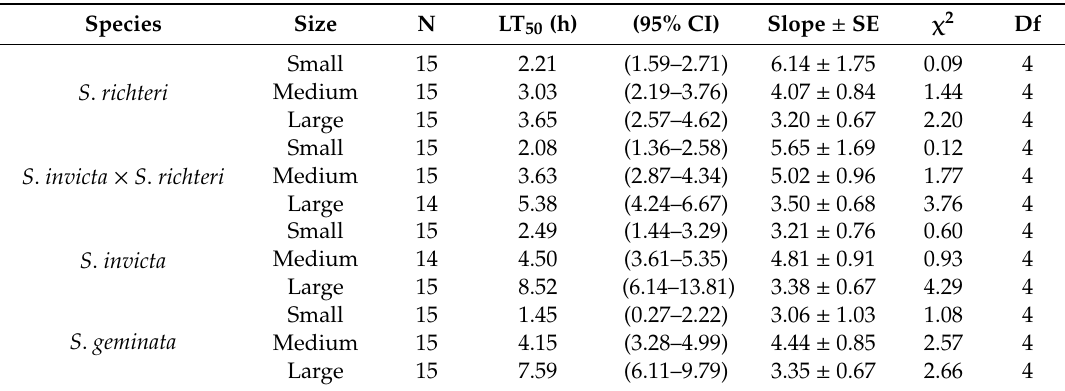
N, numbers of individuals; CI, confidence interval. Table 4. Percentage of total body water (%TBW) lost at median time of death; at lower and upper confidence intervals (CI) for live small, medium, and large workers of S . richteri , S . invicta × S . richteri , S . invicta , and S . geminata desiccated at 30 °C and 0–2% RH.